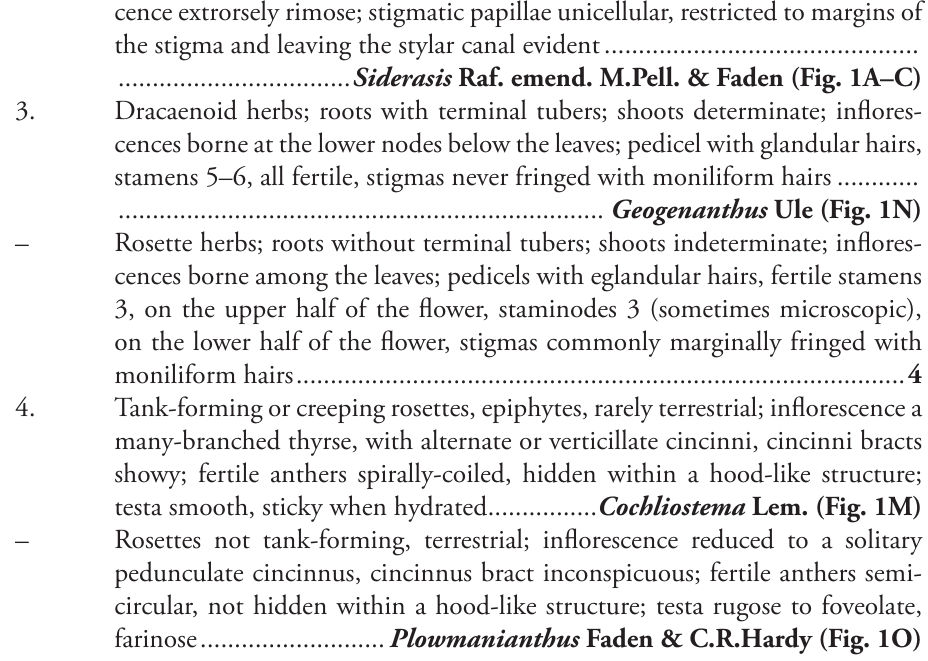
Dracaenoid herbs; roots with terminal tubers; shoots determinate; inflores-